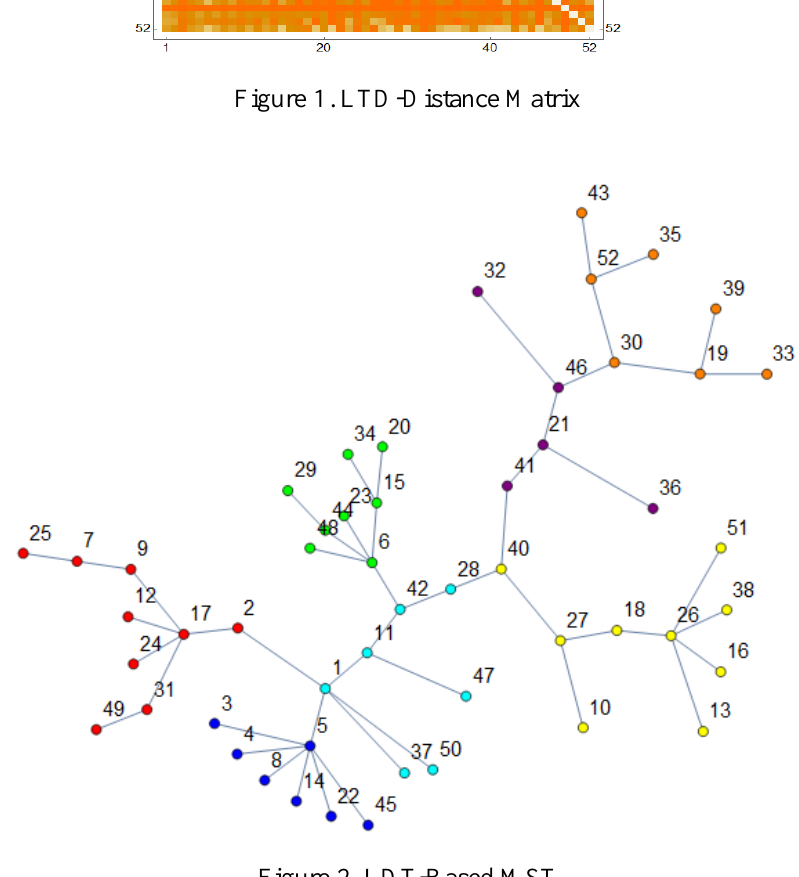
Figure 2. LDT-Based